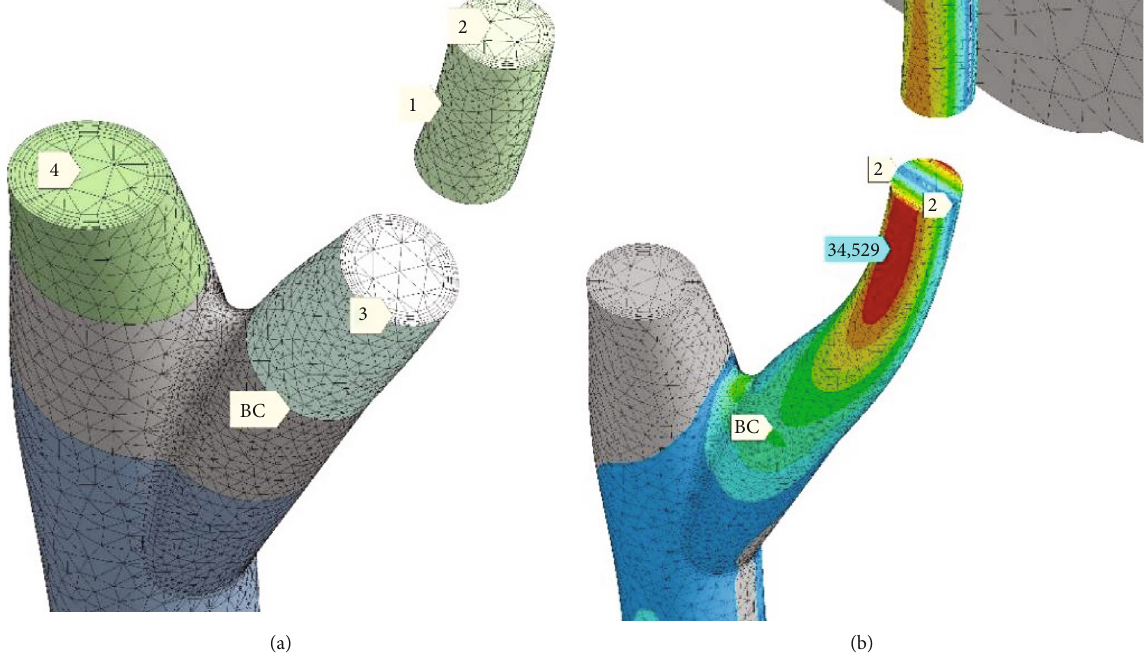
Figure 6: Dense mesh for split solids (D-mesh): (a) partial view at solids; (b) picture of equivalent stress ( σ (stated